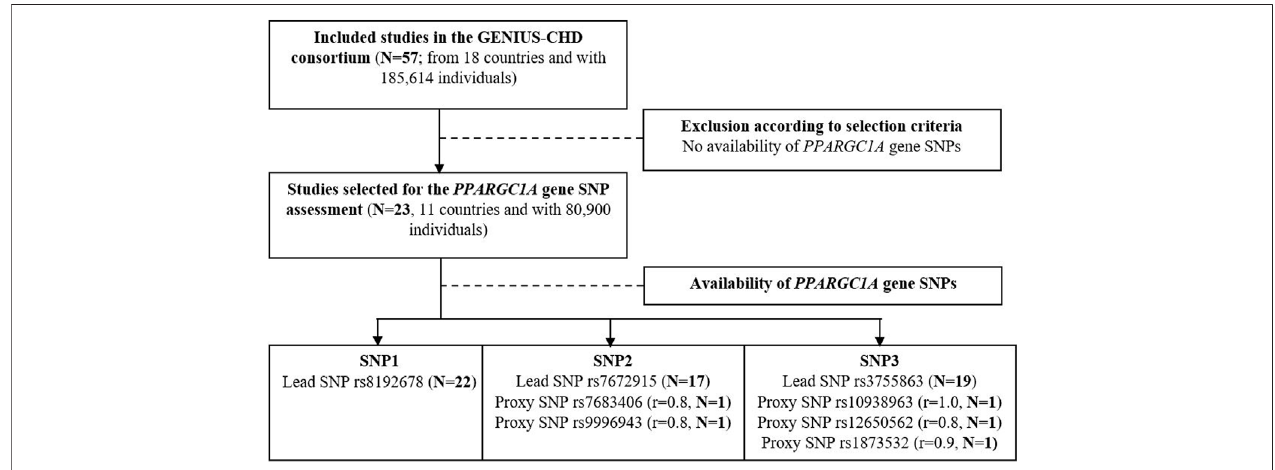
FIGURE 1 | Flow chart of study selection criteria and available SNPs for the primary outcome. Correlation between lead and proxy SNP is indicated by r (source: LDproxy Tool; ldlink.nci.nih.gov in